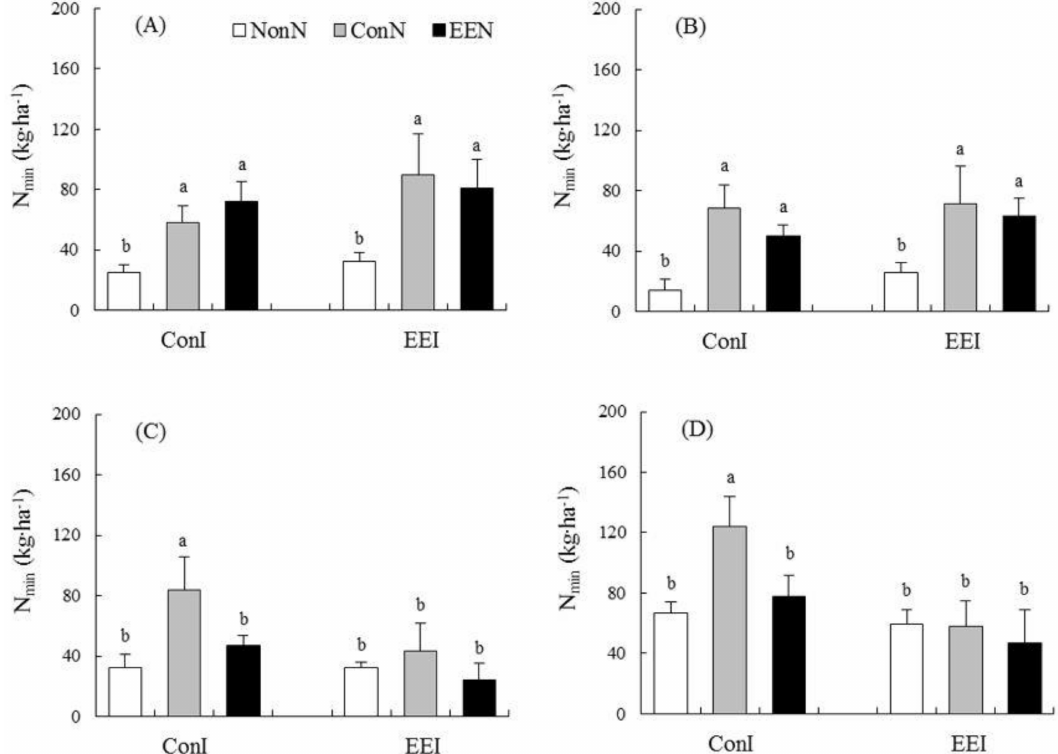
Figure 2. Soil mineralizable N (N min ; kg ha − 1 ) in the 0–60 cm and 60–120 cm soil layers after cotton harvest. ( A , C ) represent 0–60 cm and 60–120 cm soil layers of Cele, respectively; ( B , D ) represent the 0–60 cm and 60–120 cm soil layers of Shihezi, respectively. “NonN”, “ConN”, and “EEN” represent none nitrogen (N) fertilization, conventional N fertilization, and efficiency-enhanced N fertilization, respectively. “ConI” and “EEI” represent conventional irrigation and efficiency-enhanced irrigation, respectively. The values (mean ± s.e) sharing the same letter are not significantly different at p <